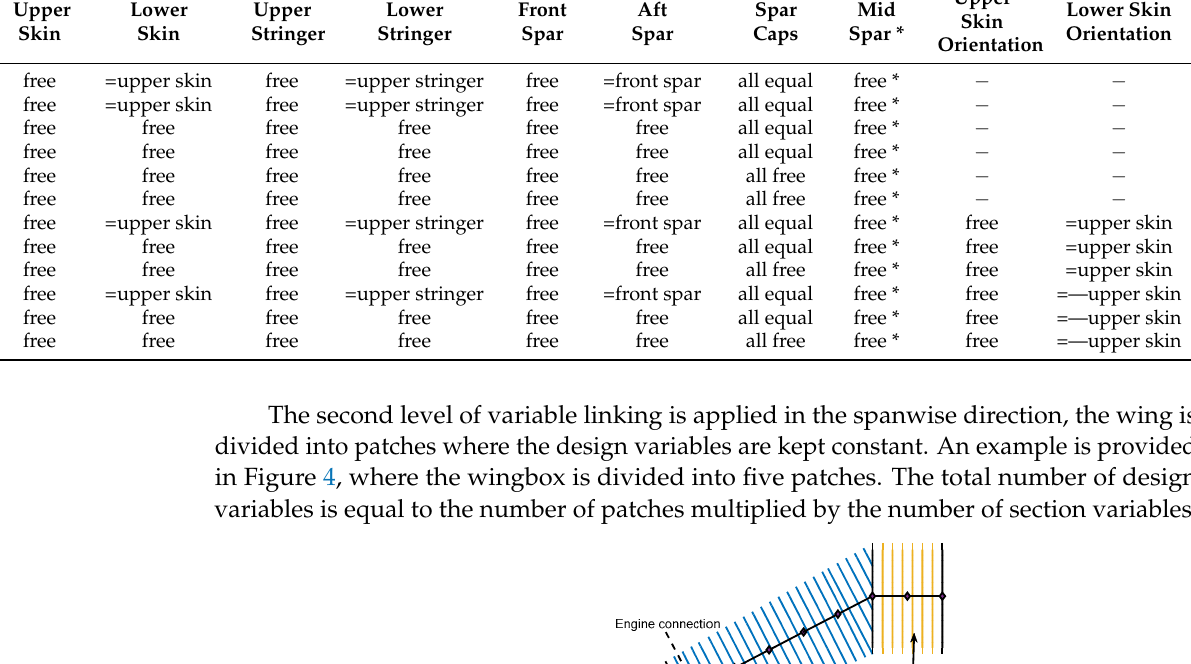
Table 1. Available section variable linking (* if intermediate spars are present).